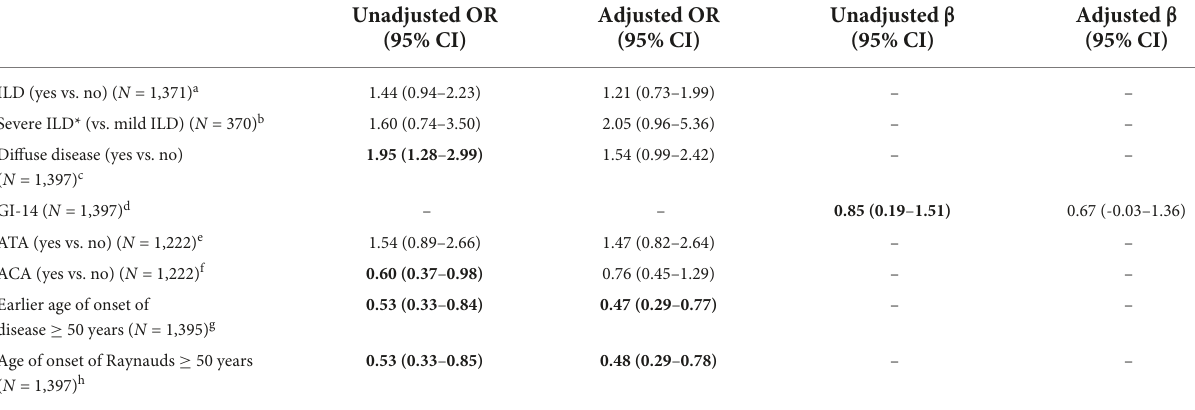
TABLE 4 Association between health outcomes and exposure to silica (yes vs. no).